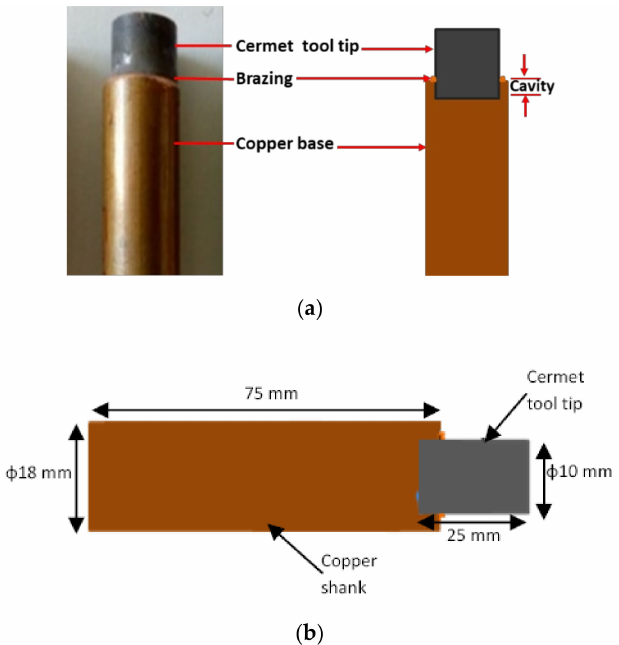
Figure 2. ( a ) Cermet tool tip electrode developed ( b ) Dimensional details of the electrode